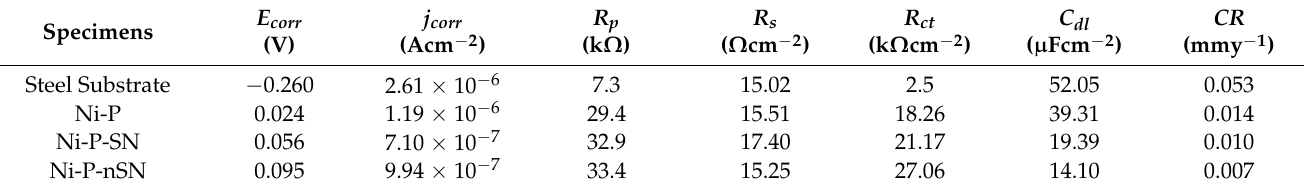
Table 1. The corrosion parameters obtained from Tafel extrapolation and Nyquist curve